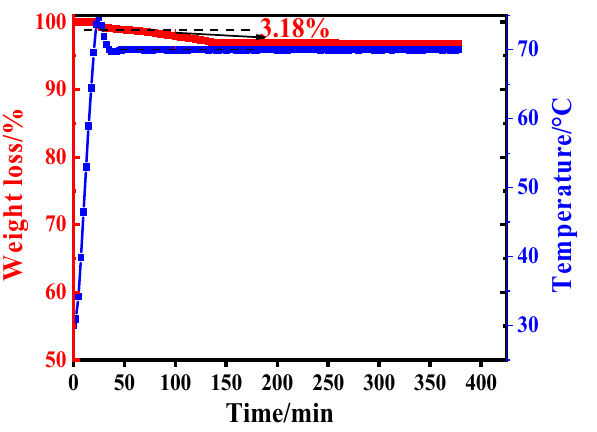
Figure A1: Infrared curve of EP@SB before and after washing for 3 h.